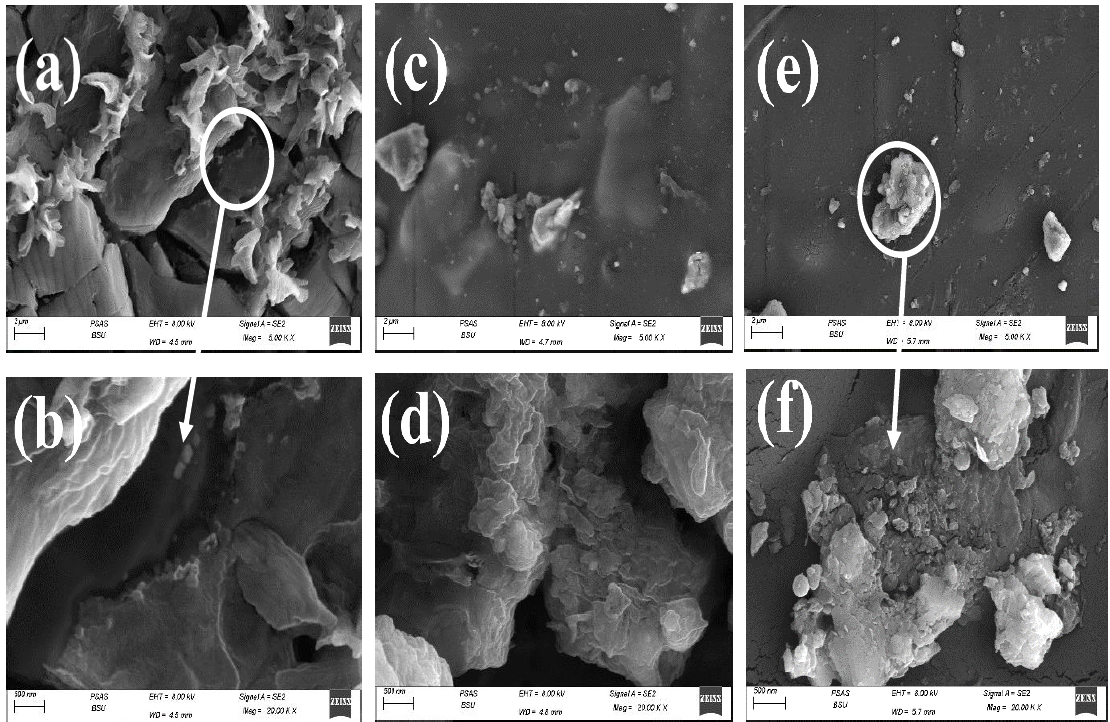
Figure 3. SEM images of: ( a , b ) Yb 2 O 3 @CS, ( c , d ) Yb 2 O 3 /V 2 O 5 @CS, ( e , f ) Yb 2 O 3 /V 2 O 5 /GO@, CS.